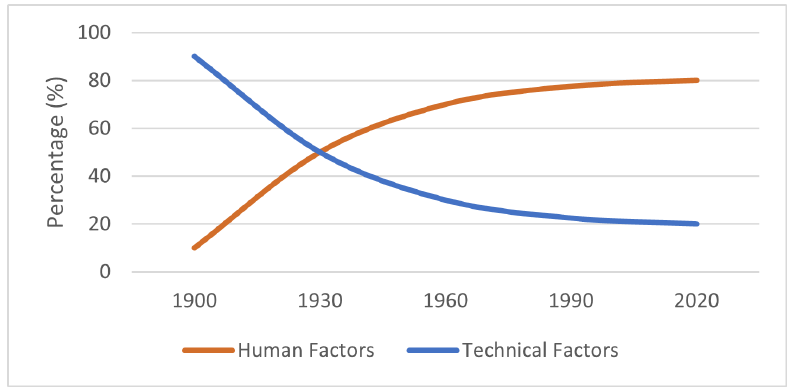
Figure 2. Evolution of aviation accident causes (adapted from